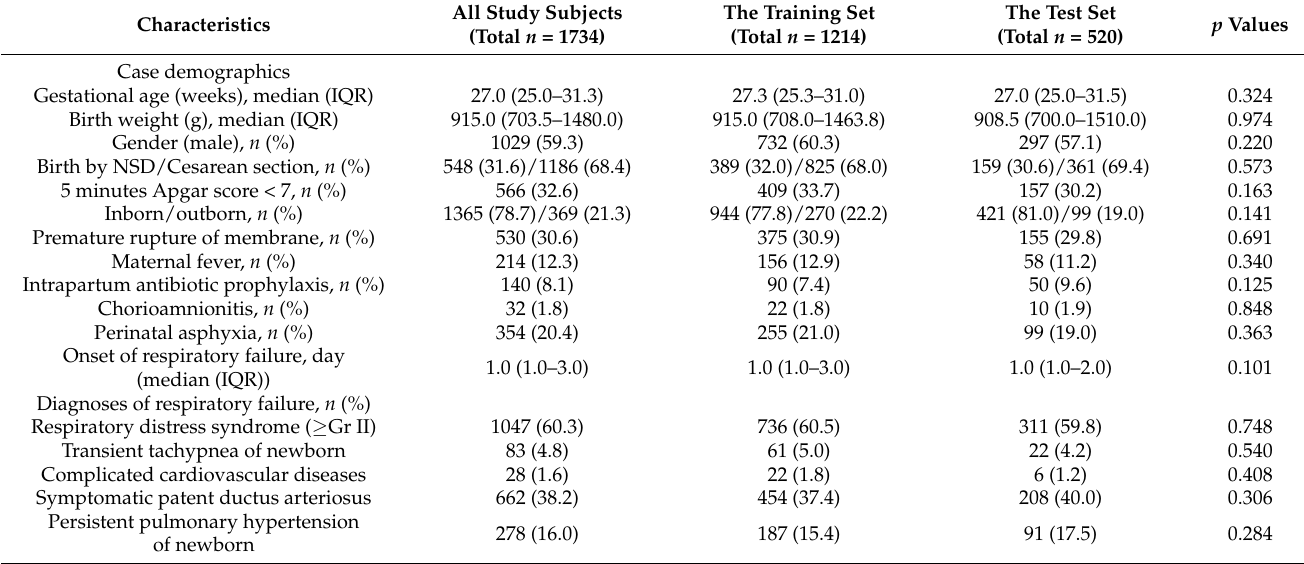
Table 1. Patient demographics, characteristics, and clinical presentation of all neonates with respiratory failure.